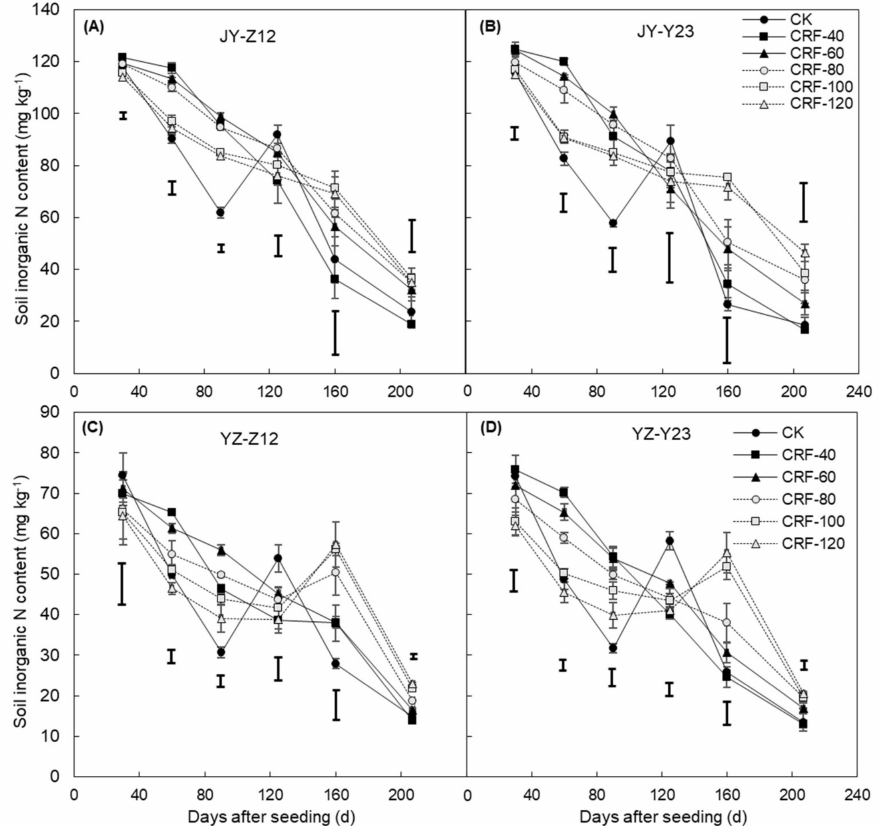
Figure 3. Dynamics of inorganic N content in 0–20 cm soil layer in different CRF treatments in Jiangyan ( A , B ) and Yangzhou ( C , D ) sites during wheat growing season. CK, conventional urea with a four-split application; CRF-40, CRF-60, CRF-80, CRF-100, CRF-120, one-time basal application with the mixture of conventional urea and controlled release urea with the release longevities of 40, 60, 80, 100 and 120 days respectively. Error bars represent SE from mean ( n = 6). Bold bars represent LSD 0 . 05